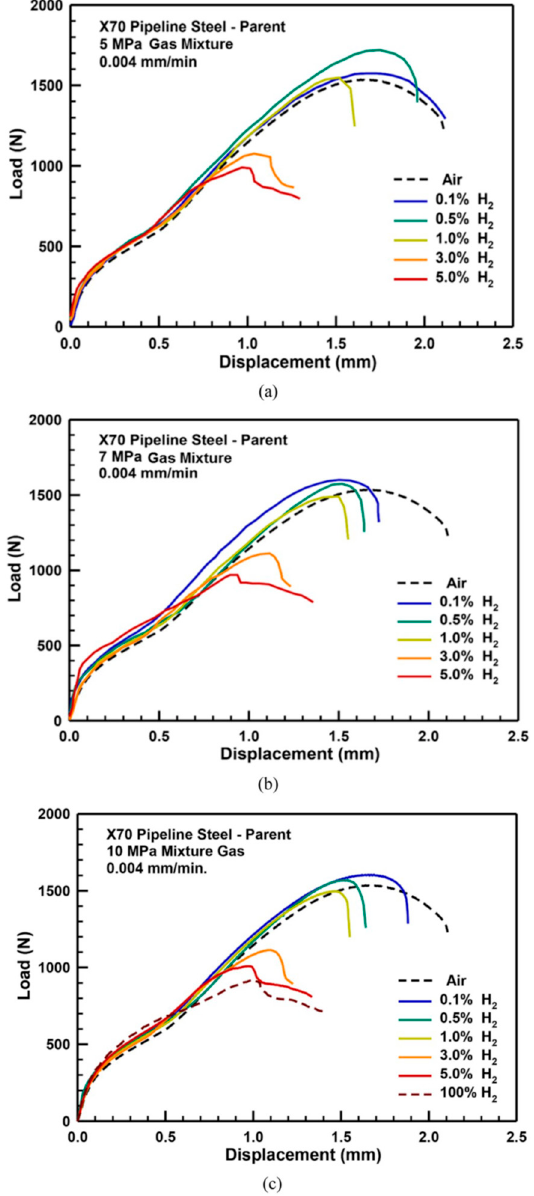
Figure 10. Load–punch displacement curves of SP test with respect to variations in the gas mixture at ( a ) 5 MPa, ( b ) 7 MPa, ( c ) 10 MPa [53].